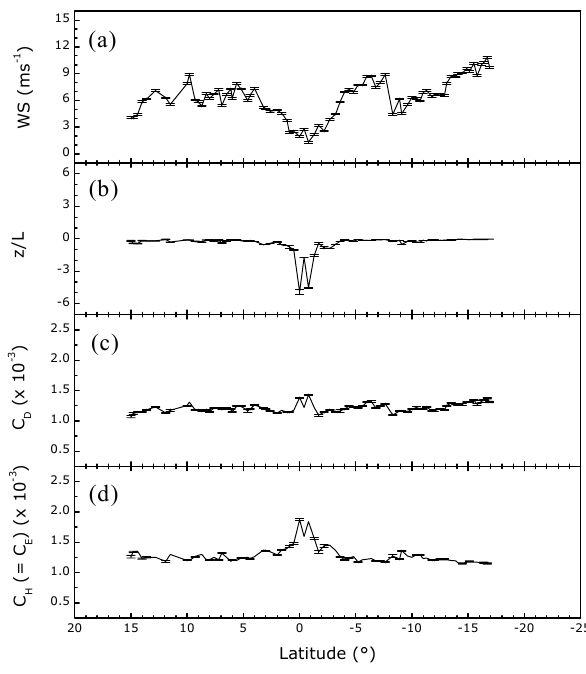
Fig. 4. Longitudinal variation of air-sea interaction parameters along cruise leg-2. (a) Wind Speed ( WS ,ms − 1 ); (b) Stability Pa- rameter ( z/L ); (c) Drag Coefficient ( C D , × 10 − 3 )); (d) Sensi- ble Heat and Water Vapour exchange coefficients ( C H and C E , × 10 − 3 ).